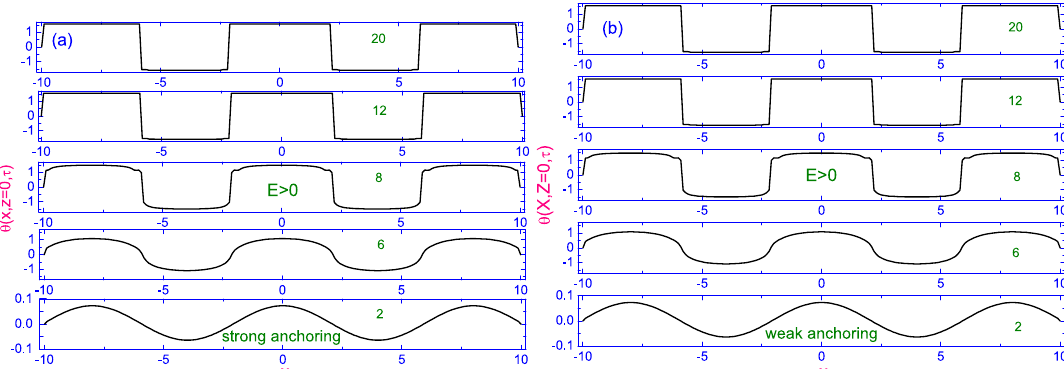
Figure 10. Plot of the evolution of the polar angle θ ( x,z = 0, τ ) to its equilibrium distribution along the length of the dimensionless nematic film ( − 10 ≤ x ≤ 10 ) , for a number of dimensionless times τ = 2 ( ∼ 12 ms), 6 ( ∼ 36 ms), 8 ( ∼ 48 ms), 12 ( ∼ 72 ms), and 20 ( ∼ 0.12 s) [19], respectively. ( a ) shows the case B, while ( b ) shows the case A during the turned-on process (E > 0. In all these cases θ 0 = 0.01 ( ∼ 1.1 ◦ ) and α = 1.57 ( ∼ 89.96 ◦ )